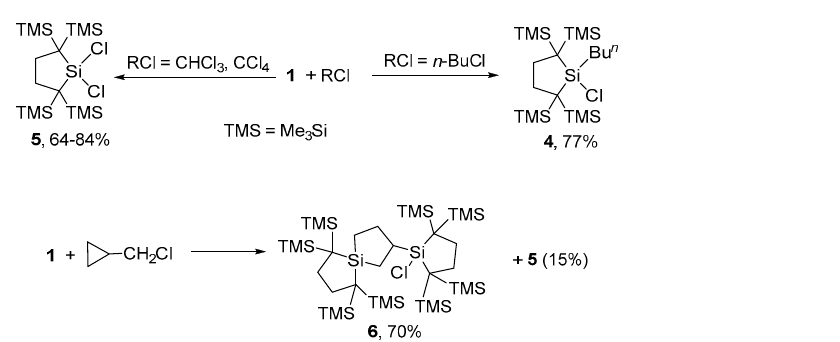
2.4. Mechanistic